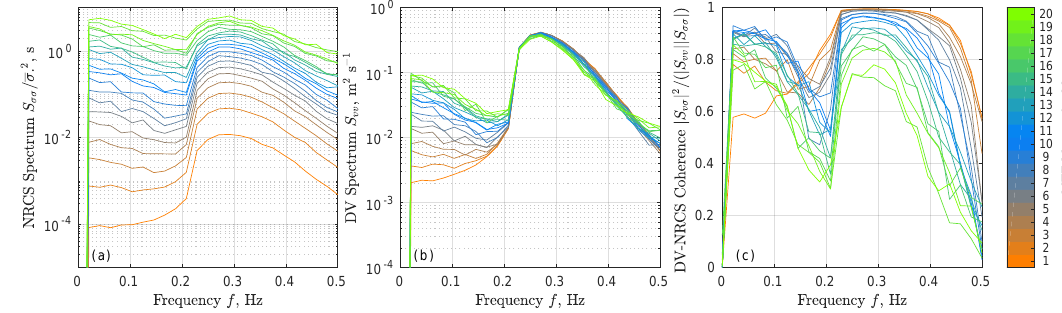
Figure 11. The same as Figure 10 but for various MTF magnitude M in Equation (10). The footprint size D = 4